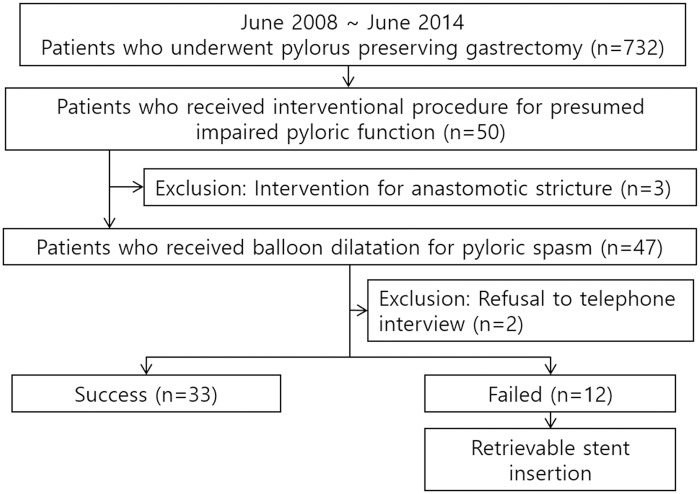
A flow diagram of our study population.